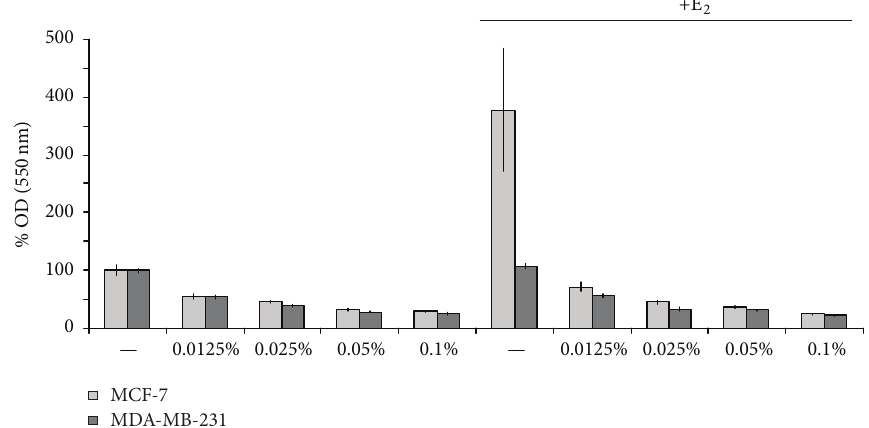
Figure 4: Effect of THIAA on E 2 -stimulated MCF-7 cell proliferation in steroid-free culture medium. MCF-7 cells were grown during 72 h in the absence (control) or presence of E 2 at 10 −9 M with or without THIAA at indicated concentrations. Cell proliferation was measured by crystal violet staining. Data refer to the mean value ± SD of a representative experiment performed independently three times in sixplicate.